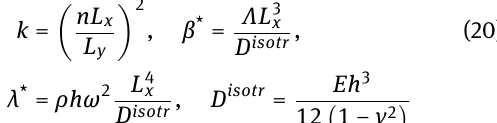
Figure 6: Distributions of the Young modulus for different configura- tion of the nanoplatelets reinforcement and the polymer matrix: a) N=16, b) N=8.